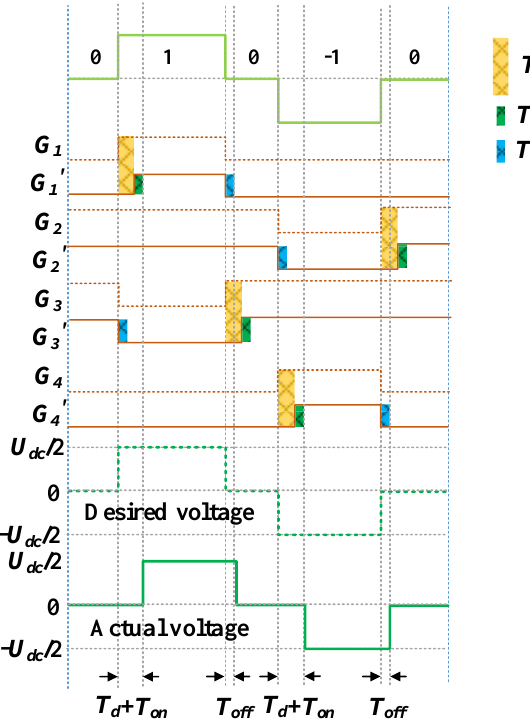
Figure 3. The gate signal with the dead-time delay and actual voltage of the TL-NPC.